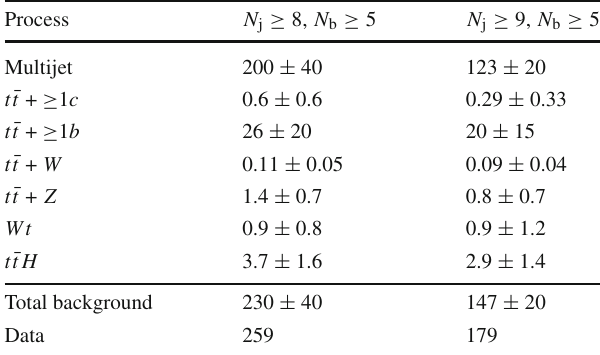
Fig. 6 Expected background and observed number of events in different jet and b -tag multiplicity bins. The background is estimated by including all bins in a background-only fit and is plotted separately for each contribution. An example signal → ¯ b ¯ b ¯ s yield for ˜ t → ¯ b ˜ χ + ( ˜ χ + 1 1 and c.c.) production with m ˜ t = 600 GeV and m ˜ χ ± = 550 GeV is 1 overlaid. The bottom panel displays the ratios of data to the total prediction, uncertainty bars are statistical only.